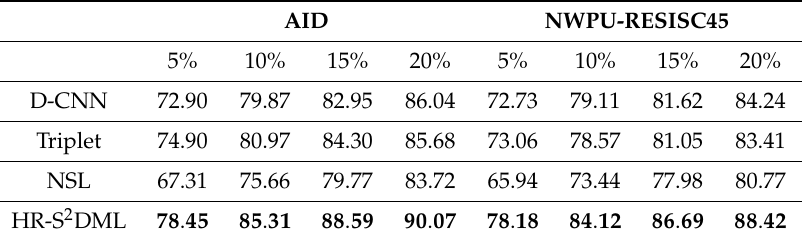
Table 2. NMI assessment (%) for the test set embeddings of the different methods, when the percentages of labeled images are 5%, 10%, 15%, and 20%,